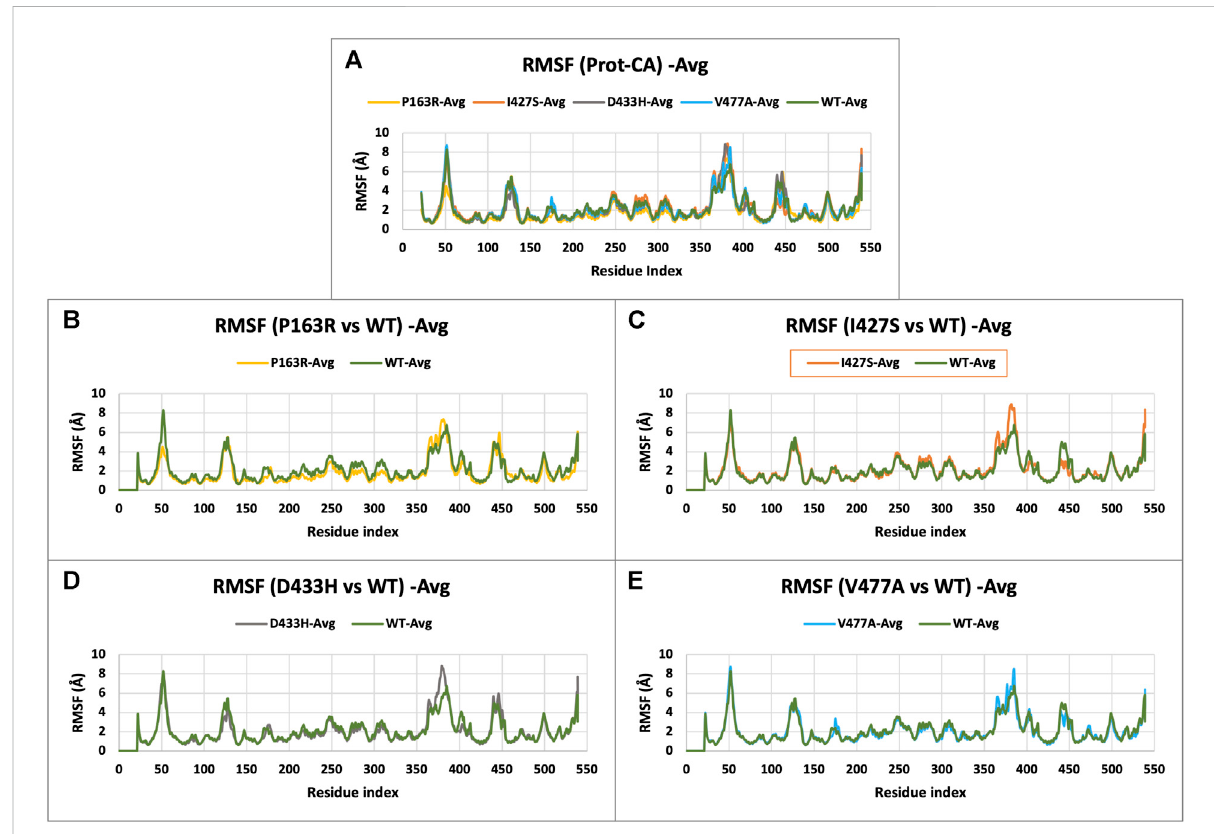
FIGURE 4 (A) RMSFplotofCaSRECDproteinC-alpha(Prot-CA)atomsthroughoutthesimulationforWTandmutantproteins. (B – E) showstheRMSFplot for mutant P163R, I427S, D433H, and V477A, respectively.